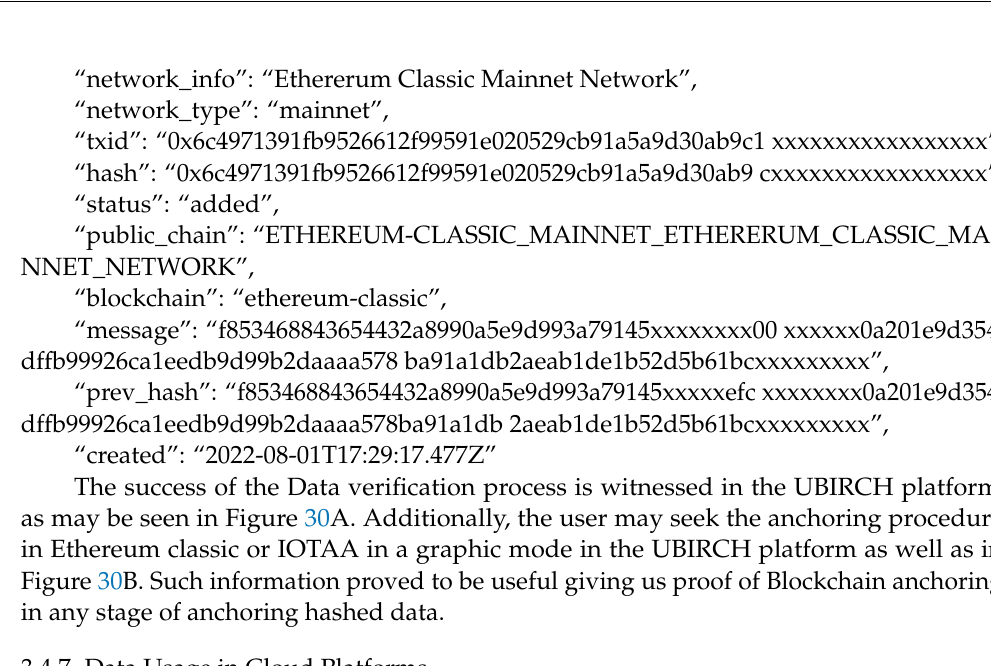
Table 3. Data Usage vs. time in